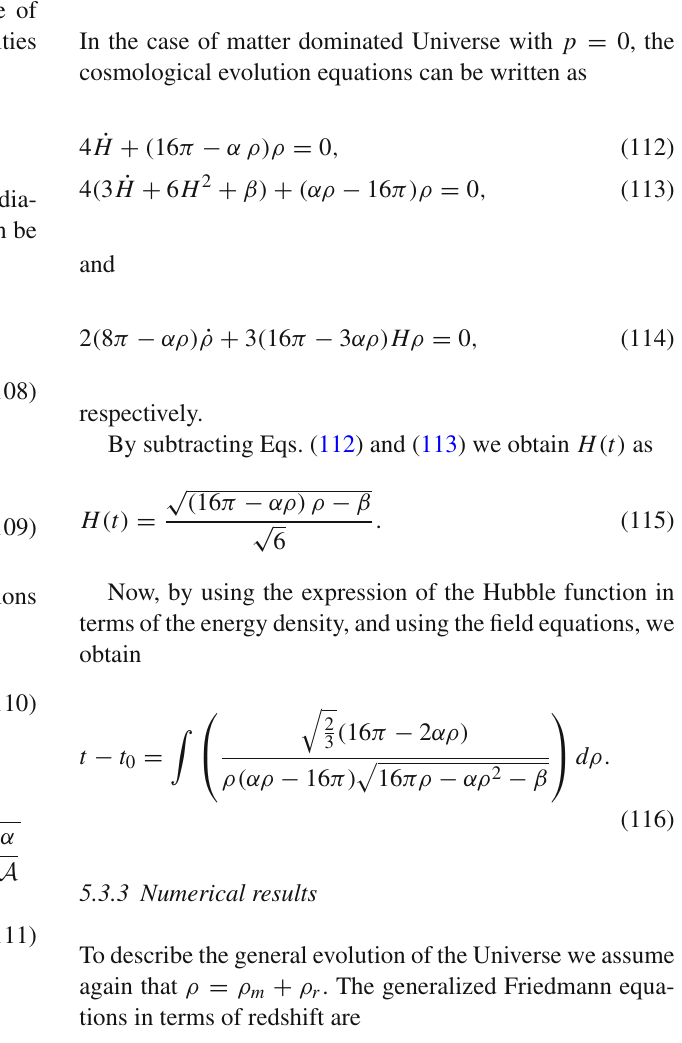
Fig. 1 TheHubblefunction(leftpanel)andthedecelerationparameter (right panel) as a function of the redshift z for the multiplicative model of the f ( R , L m , T ) theory with L m = − ρ for three different values of the constant ¯ α : ¯ α = − 0 . 002 (dashed curve), ¯ α = − 0 . 001 (dotted